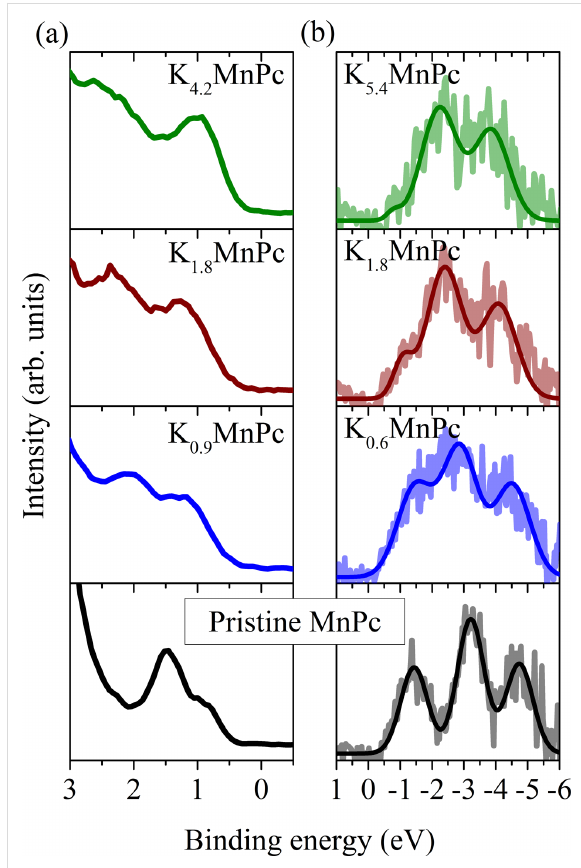
Figure 4: Panel (a): valence band photoelectron spectroscopy results for undoped and three potassium-doped MnPc films, which represent the occupied density of states. The doping levels were determined using PES from C 1s and K 2p core levels [49]. Panel (b) depicts data from inverse photoelectron spectroscopy, i.e., the unoccupied density of